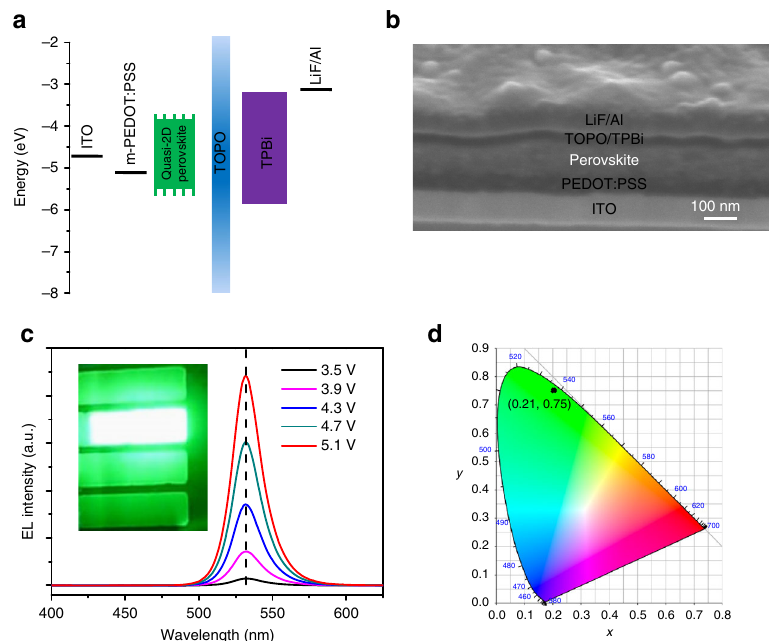
Fig. 3 Perovskite light-emitting diodes structure and electroluminescence. a Band alignment of each function layer in the devices. b Cross-section scanning electron microscopy (SEM) image of the device, the scale bar is 100 nm. c Typical electroluminescence (EL) spectra of PEA 2 (FAPbBr 3 ) n -1 PbBr 4 ( n = 3 composition) based PeLEDs under different voltage bias. Inset shows the electroluminescence image of PeLEDs. d The corresponding Commission Internationale de l ’ Eclairage (CIE) coordinate of typical PeLEDs based on PEA 2 (FAPbBr 3 ) n -1 PbBr 4 ( n = 3